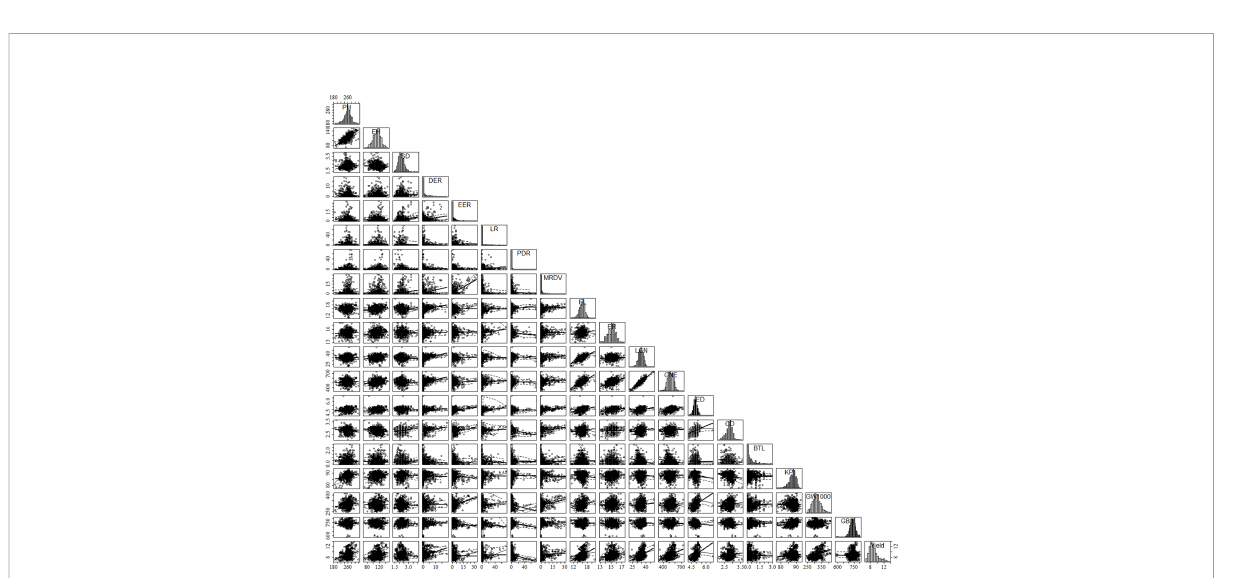
FIGURE 4 Scatterplot matrix of plant agronomic traits and yield based on literature data. The matrix was created by using the car package in R software. Diagonal panels show the distribution of each variable. Lower panels show the scatterplot between two different parameters: x-axis, column variable; y-axis, row variable. PH, plant height, cm; Ell, ear height, cm; SD, stem diameter, em; DER, Double ear rate, %; EER, empty ear rate, %; IR, lodging rate, %; PDR. Pour the discount rate, %; MRDV, maize rough dwarf virus, %; EI, var length, cm; ER, car rows; LGN. line grain number; GNE, grain number per ear; ED, ear diameter, cm; CD, cob diameter, cm; BTL, bald tip long, cm; KP, kernel percentage, %; GW1000, 1000 grains weight, g: GBD, grain bulk density, g L -1